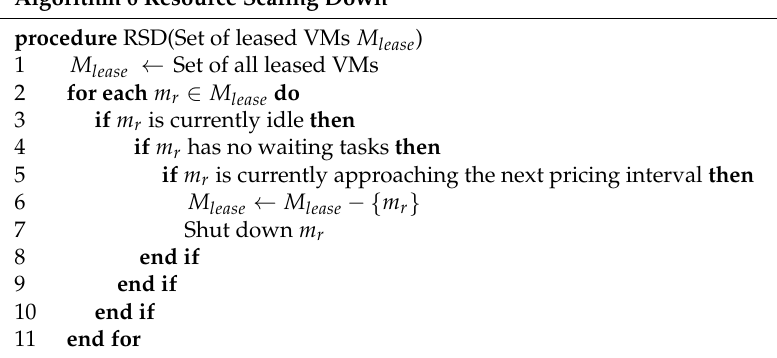
Algorithm 6 Resource Scaling Down